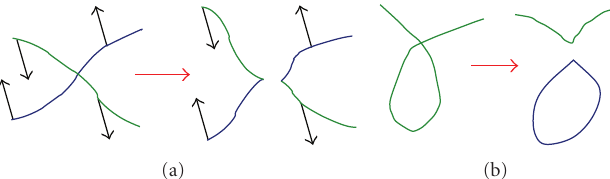
Figure 3: Intercommuting strings exchanging their partners (a). On (b), the same mechanism produces a loop from a self-intercommuta- tion. The arrows represent velocity vectors.